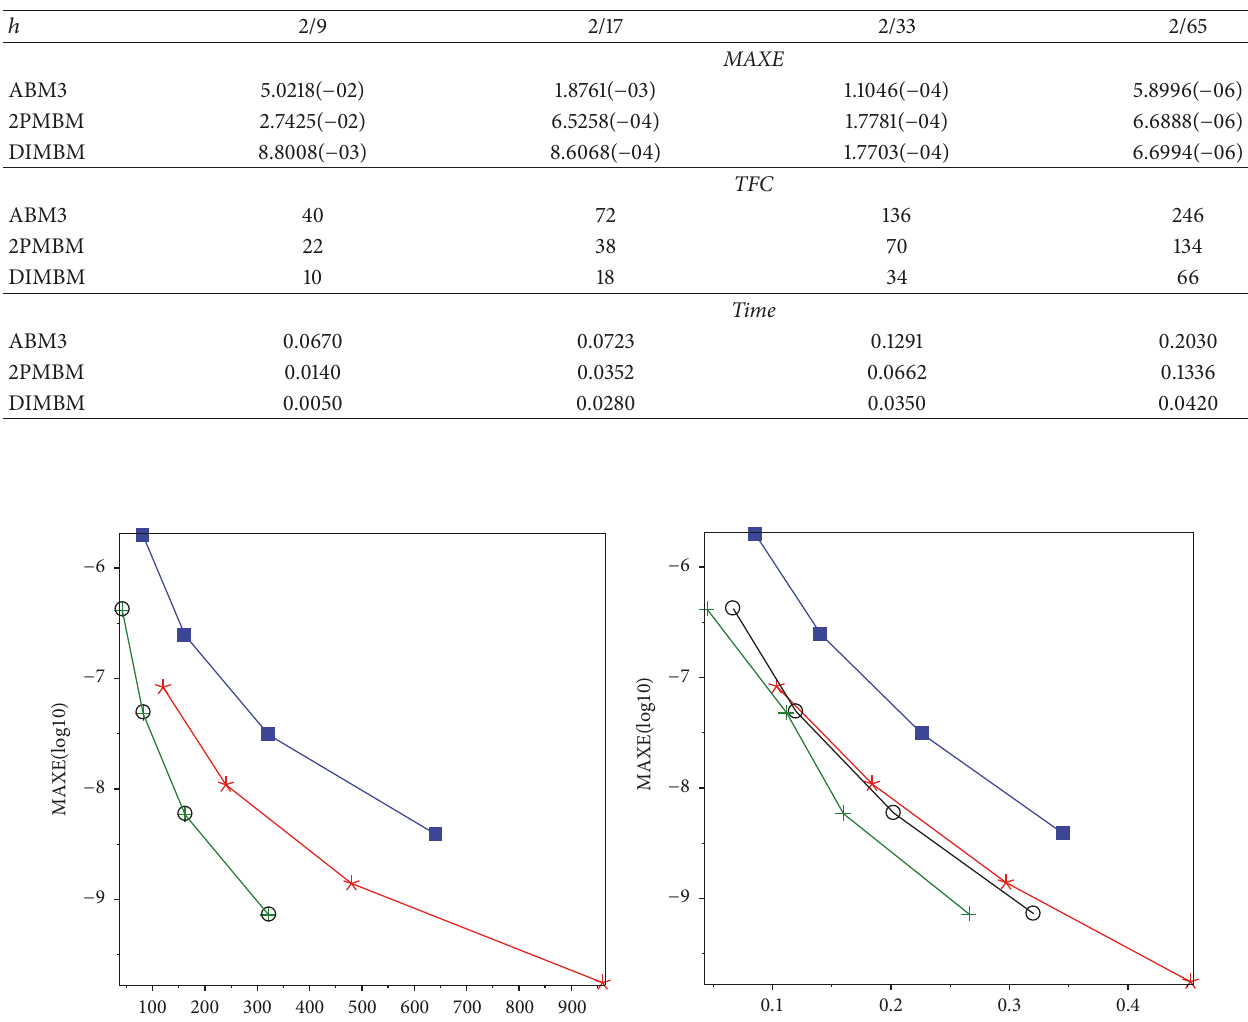
Table 4: Numerical results for Example 4.